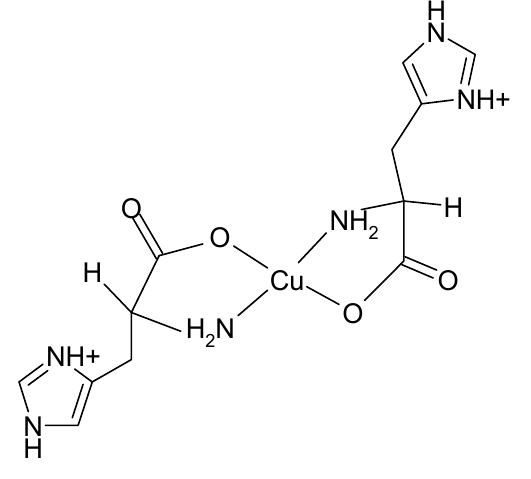
complex at acidic 2